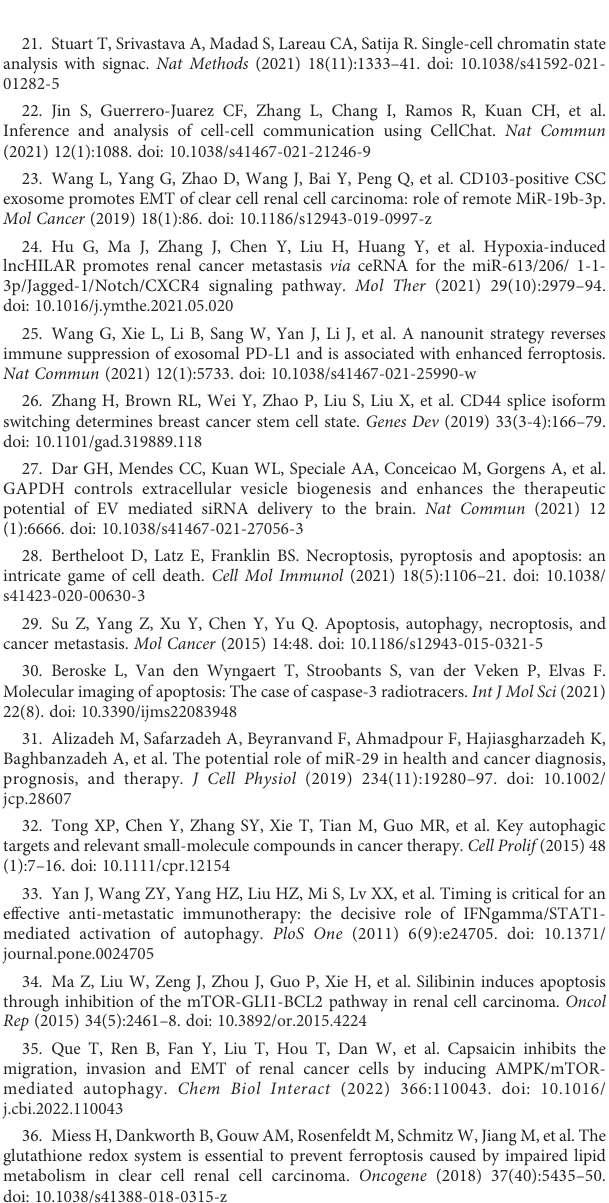
according to stages I – IV. The differences in the expression of candidate biomarker genes were compared between groups, and P < 0.05 genes were retained. SUPPLEMENTARY FIGURE 6 A total of 13 genes in 10 main cell clusters. Violin plot showing the differential analysis of key genes in various cell clusters. SUPPLEMENTARY FIGURE 7 Violin plot showing the differential analysis of CD44 and GAPDH in tumor cells versus TRIB3 high tumor epithelial cells.